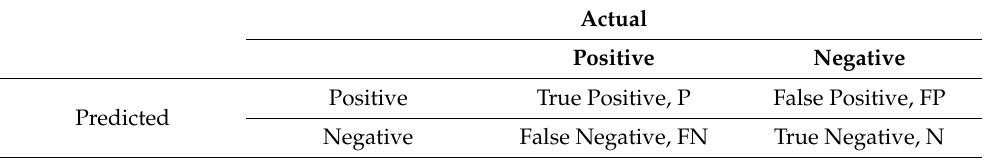
Table 2. Confusion matrix used in performance analysis.